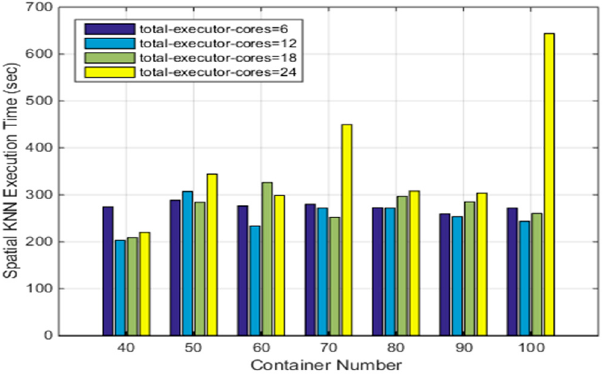
Figure 9. The impact of total executor cores and container number on the efficiency of SNNQAs using ASVC.